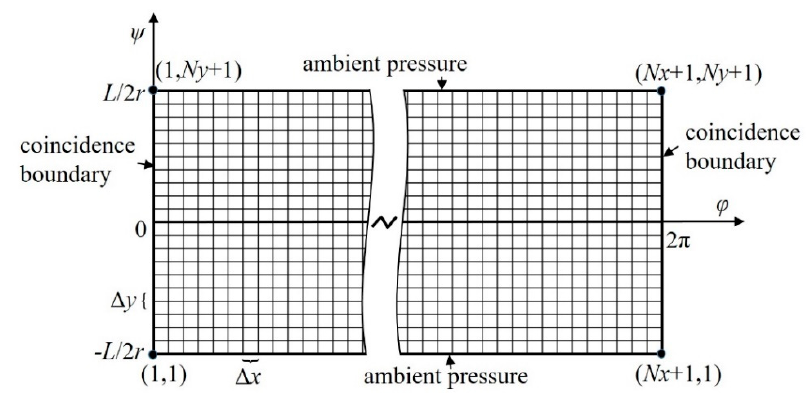
Figure 4. Schematic diagram of a typical bearing-rotor system.